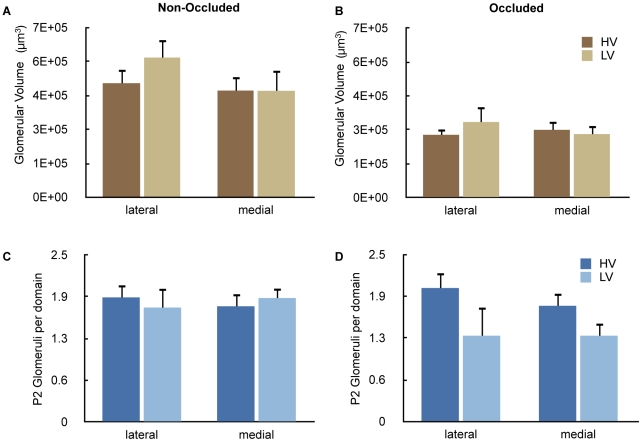
Naris occlusion abolishes the difference in glomerular volume and glomerular number between animals raised in different environments.
A and B. Glomerular volume: A (non-occluded naris) and B (occluded naris). Occlusion of one naris abolished the difference in glomerular volume between HV and LV cages. A mixed effects ANOVA showed no differences in glomerular volume between different cage types (F1,37 = 0.37, P = 0.55). We did find significant differences in glomerular volume between the naris occluded and unoccluded sides (F1,100 = 16.7, P<0.0001). C and D. Number of glomeruli: C (non-occluded naris) and D (occluded naris). A mixed effects ANOVA showed no differences in glomerular number between different cage types (F1,20 = 1.82, P = 0.19) and between occluded and unoccluded sides. The data in the LV cages is reproduced with permission from a previous publication in the Journal of Comparative Neurology [15].